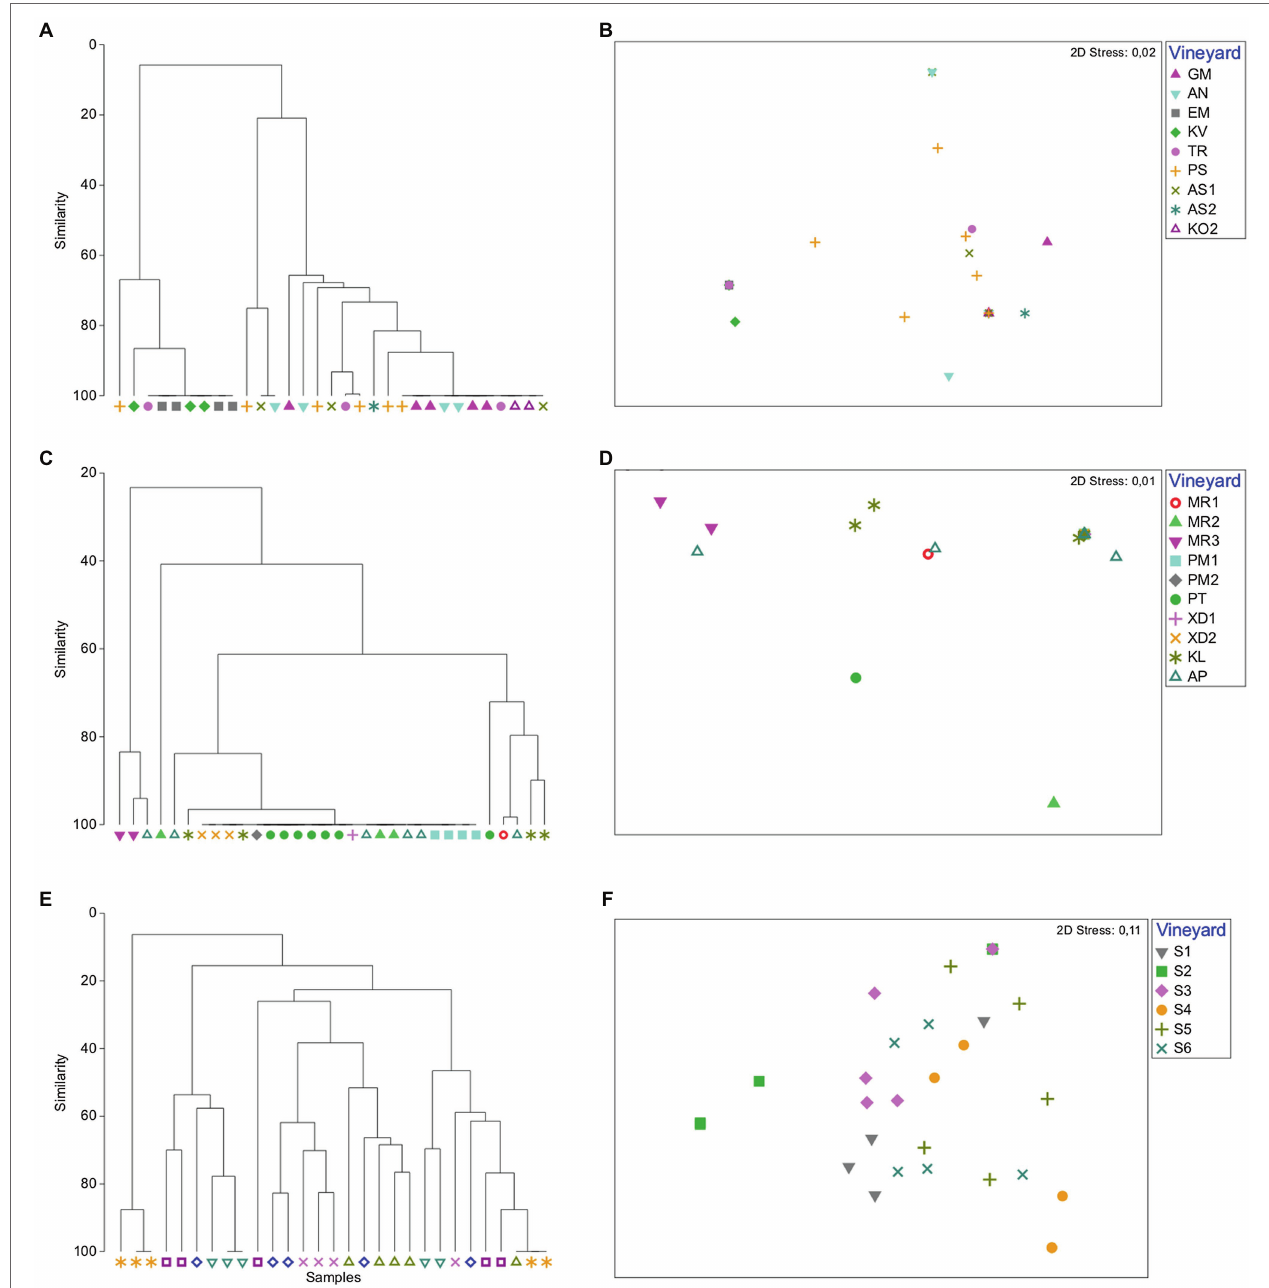
FIGURE 4 | Bray–Curtis non-metric multidimensional scaling plots and dendrograms of yeast community vineyard samples in Nemea (A,B) , Peza (C,D) , and Santorini (E,F) ,